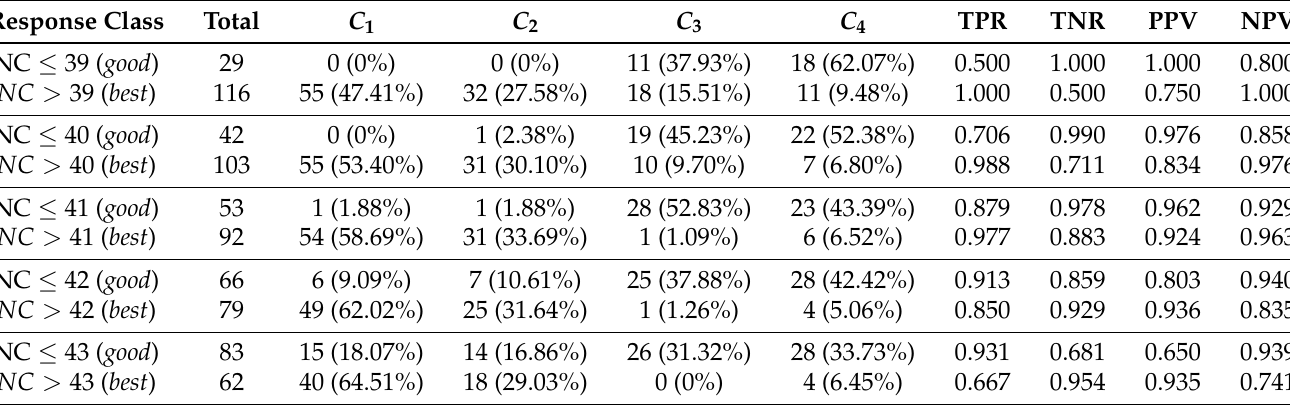
Table 7. Classification of patients from D 1 into communities C 1 – C 4 based on the NC threshold values within range 39–43 cm. We provide the corresponding statistical tests for each of the two response classes, good and